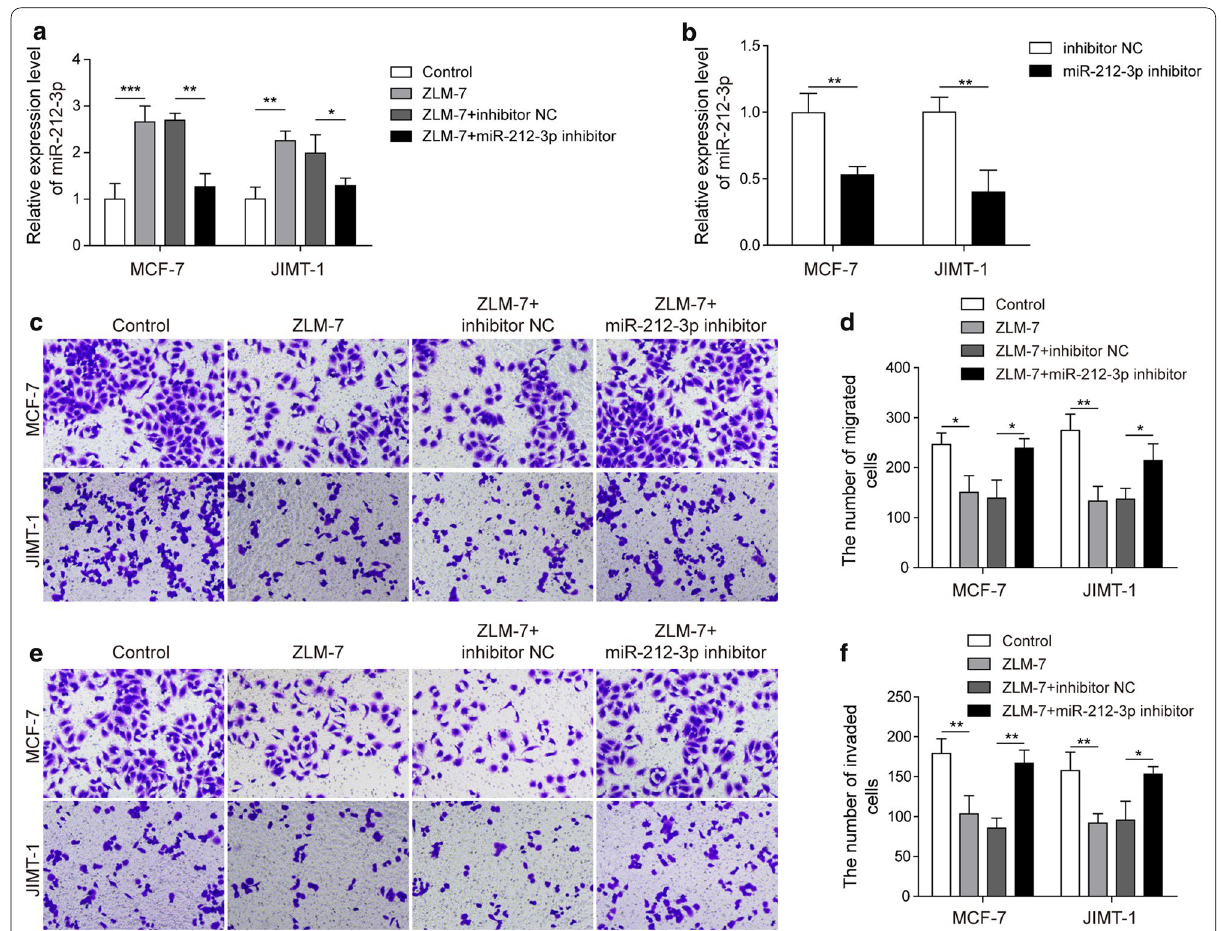
Fig. 1 ZLM‑7 inhibited the migration and invasion of BC cells by up regulating the expression of miR‑212‑3p. a Relative expression of miR‑212‑3p in MCF‑7 and JIMT‑1 treated with ZLM‑7, miR‑212‑3p inhibitor or NC by qRT‑PCR analysis. b Expression level of miR‑212‑3p in MCF‑7 and JIMT‑1 after transfection with miR‑212‑3p inhibitor. c , d Cell migration of MCF‑7 and JIMT‑1 detected by transwell assay after ZLM‑7 and miR‑212‑3p inhibitor treatment. e , f Cell invasion of MCF‑7 and JIMT‑1 detected by transwell assay after ZLM‑7 and miR‑212‑3p inhibitor treatment. * P < 0.05, ** P < 0.01, *** P <